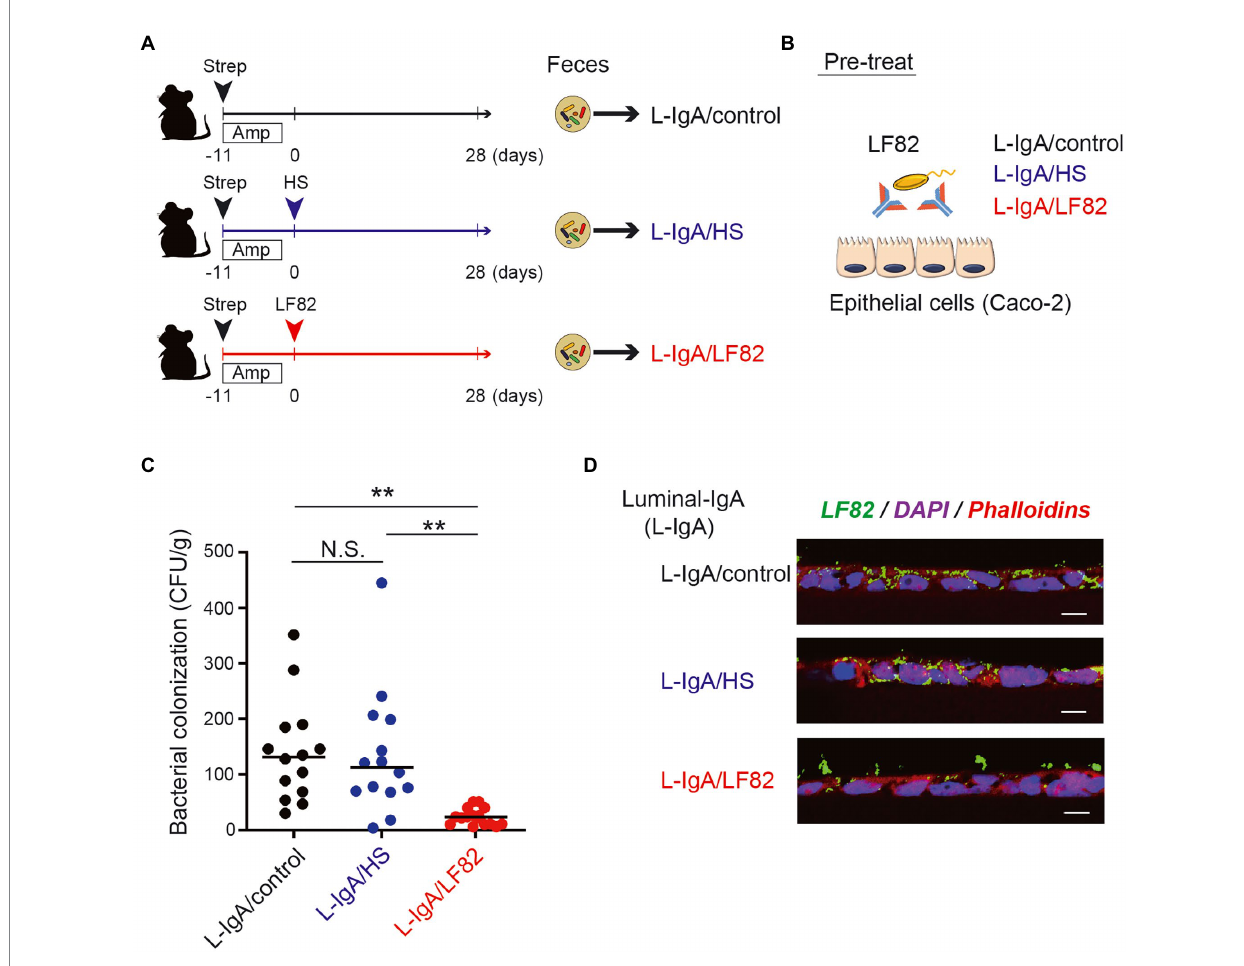
FIGURE 5 AIEC-specific IgA fraction inhibits the invasion of AIEC into the epithelial layers in vitro . (A) The IgA fractions containing luminal IgA (L-IgA) were obtained from the mice infected with HS (L-IgA/HS), LF82 (L-IgA/LF82) or without infection (L-IgA/Control), 28 days after inoculation. (B) For the invasion assay, LF82 was pre-treated with each of the IgA fractions, and its ability to invade the layer of human epithelial line, Caco-2 was examined. (C) The invasion ability of LF82 pretreated with L-IgA was assessed by the number of bacteria that resided in the epithelial layers. (D) Immunofluorescence images of the epithelial layers incubated with LF82 which was pre-treated with L-IgA from control (L-IgA/Control), HS- infected (L-IgA/HS) or LF82-infected (L-IgA/LF82) mice are shown. LF82 was visualized by the staining with anti- E.coli Ab (LF82, green), and the nucleus and cytoplasm of Caco-2 cells were, respectively, detected by the staining with DAPI (blue) and Phalloidin (red). Data shown are mean ± SD ( N = 14). N.S., not significant; **, p < 0.01 one-Way ANOVA with Bonferroni post-hoc